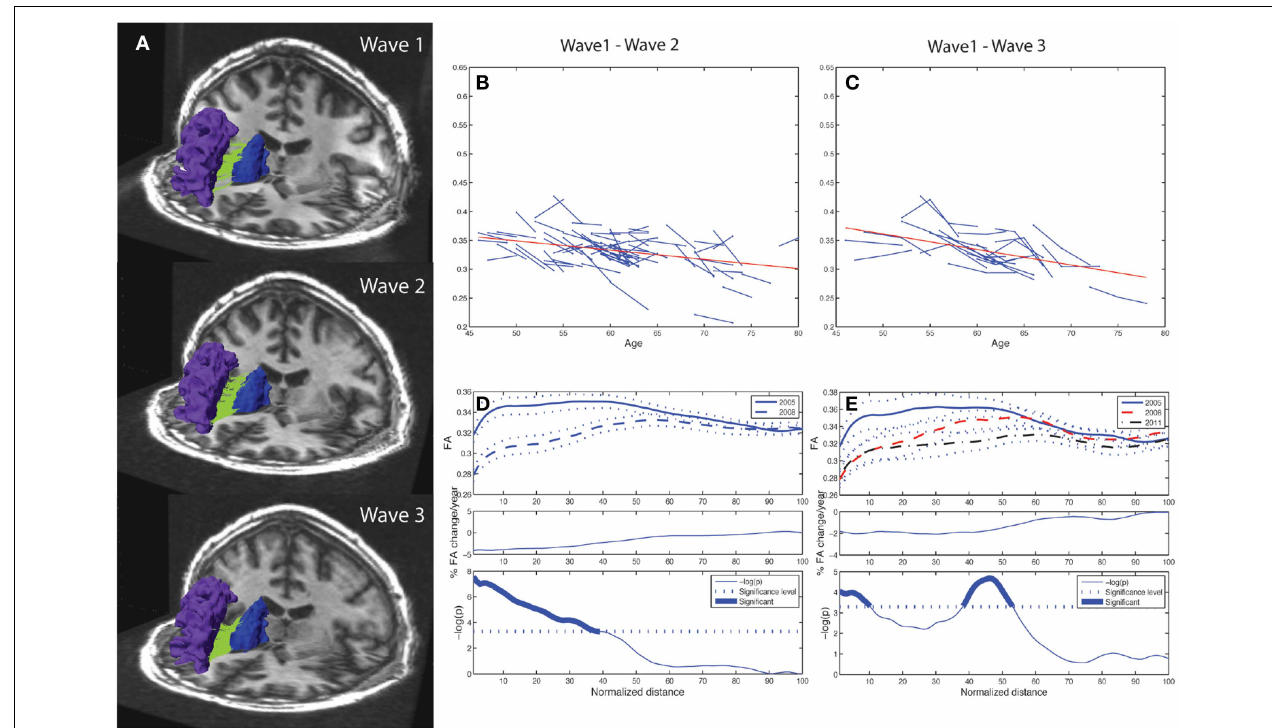
and below the mean profile), across the cohort. Note that the fiber bundle is length-normalized into 100 equidistant points along the tract. Middle panel: Average percentage change per year of FA at each segment along the fiber bundle, from Wave-1 to Wave-2, across cohort. Lower panel: Segments for which there is a significant (Bonferroni corrected p < 0.001, paired t -test) change in FA along the fiber, highlighted with a thicker line. The p -value is scaled as − log 10( p ) . (E) Upper panel: Along-tract FA profiles of fiber bundle illustrated in (A) for the subset ( N = 24) having three MRI examinations, i.e., segment-wise mean FA (continuous line in Wave-1, broken line in Wave-2, mixed broken & dotted line in Wave-3) and ± 1 SE (dotted lines), across the cohort. Middle panel: Average percentage change per year of FA at each segment along the fiber bundle, from Wave-1 to Wave-3, across subsample. Lower panel: Segments for which there is a significant (Bonferroni corrected p < 0.001, repeated measures ANOVA) change in FA along the fiber, highlighted with a thicker line. The p -value is scaled as − log 10( p )